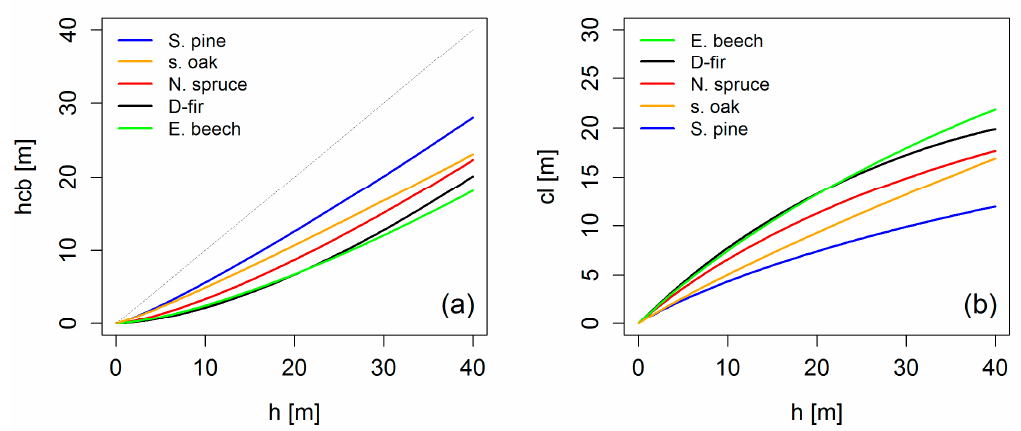
Figure 8. Species-specific ( a ) height to crown base, hcb, and ( b ) crown length, cl, for selected tree species growing in fully stocked mono-specific stands. (See model 3 in Table 1).